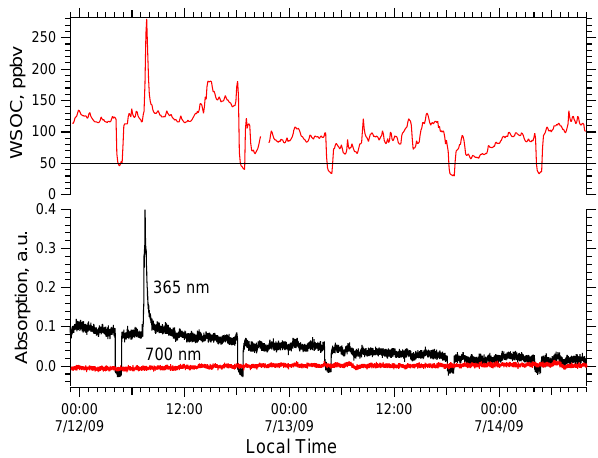
Fig. 3. Unprocessed Water-Soluble Organic Carbon (WSOC) and light absorption at two wavelengths (centered at 365 and 700nm) in Atlanta, GA. Measurements during periods of automated dynamic blank are evident in the WSOC and absorption at 365nm, but not at 700nm, the latter is used as a